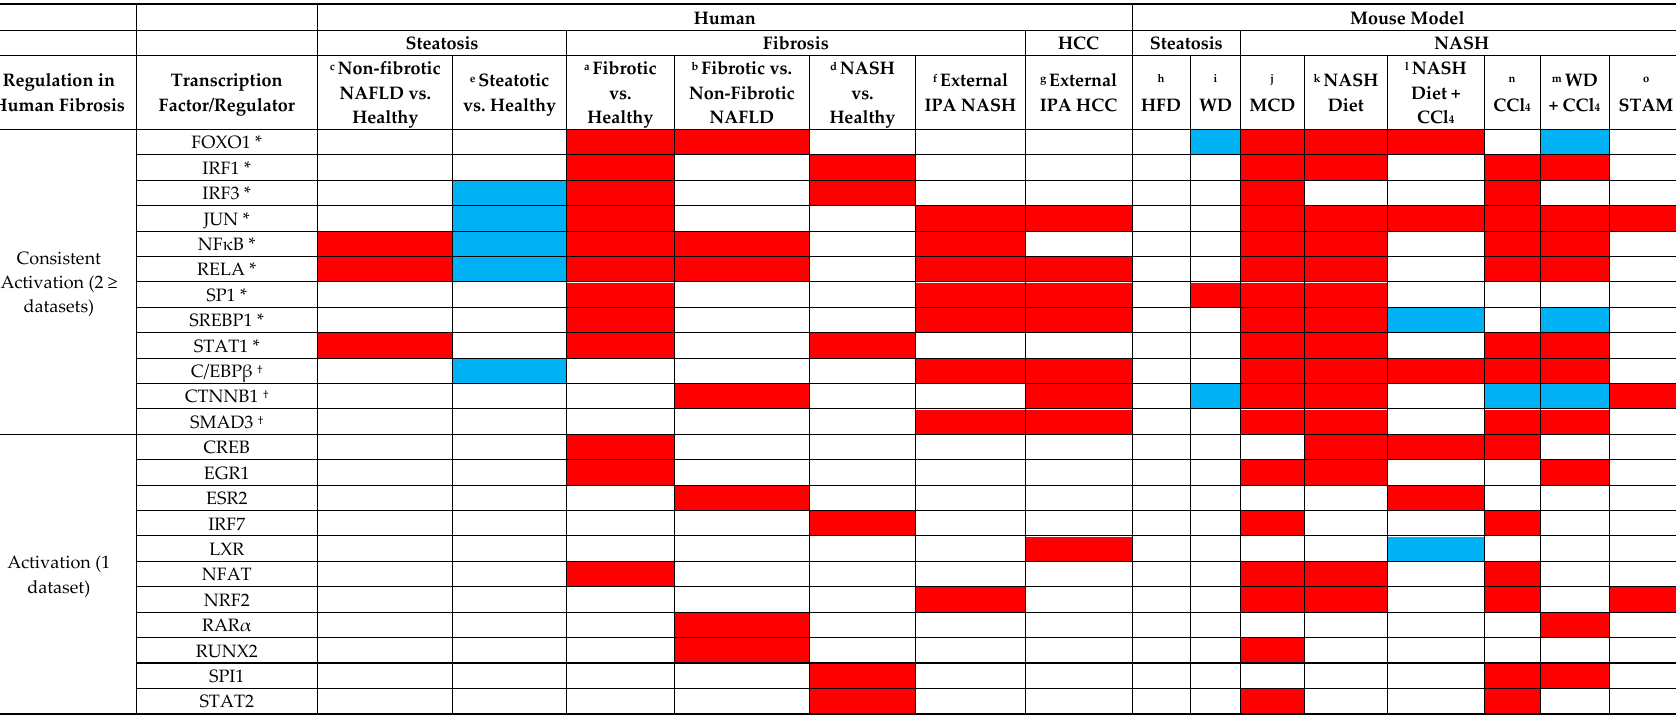
Table 2. Ingenuity Pathway Analysis (IPA) prediction of upstream mechanistic networks that are commonly regulated in the livers of humans and mice with NAFLD.